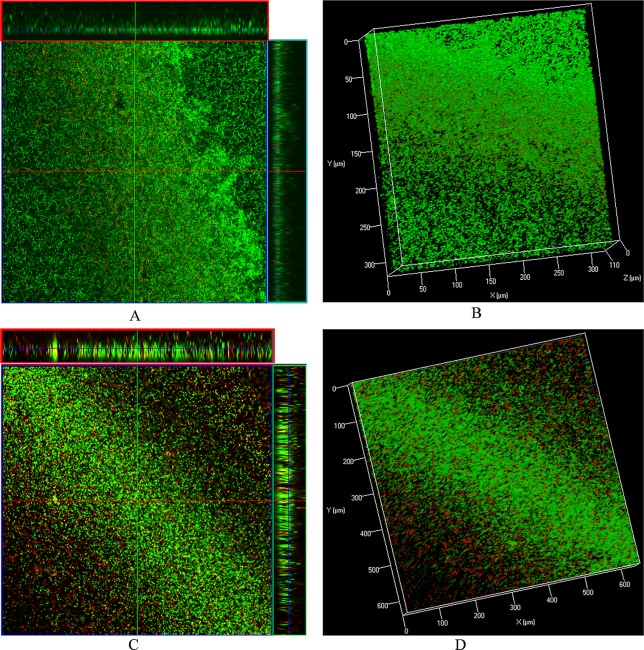
Live/dead biofilm viability staining and confocal microscopy of pre-established biofilms treated with ε-viniferin (2). (A) 2-dimensional (with ortho-section) confocal microscopy image of control biofilms and (B) 3-dimensional image of control biofilms. (C) 2-D (with ortho-section) confocal microscopy image of pre-established biofilm treated with 2 × MIC viniferin and (D) 3-D confocal microscopy image of viniferin-treated biofilms.